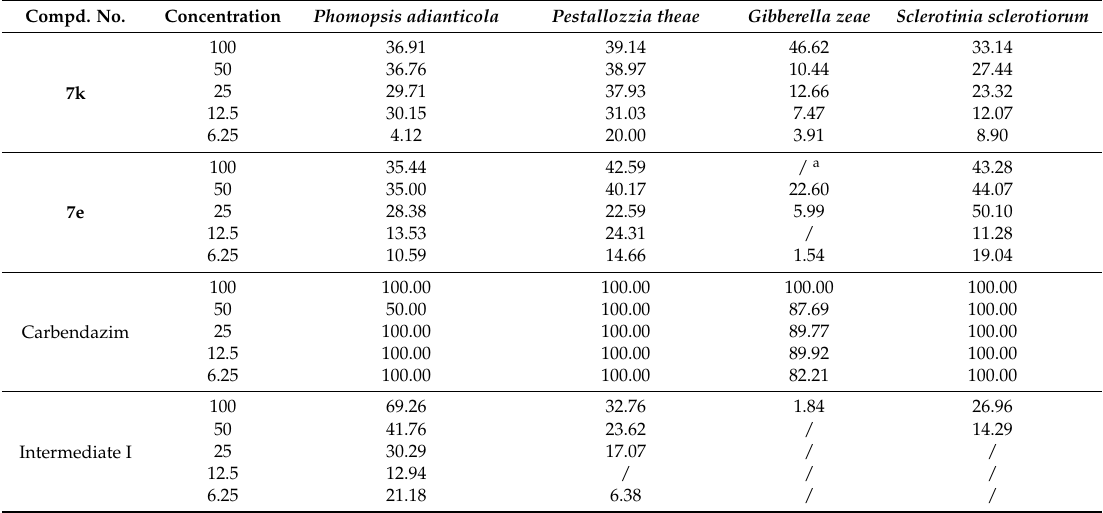
Table 2. In vitro antifungal activities of compounds 7k and 7e on four common plant pathogenic fungi. Compd.